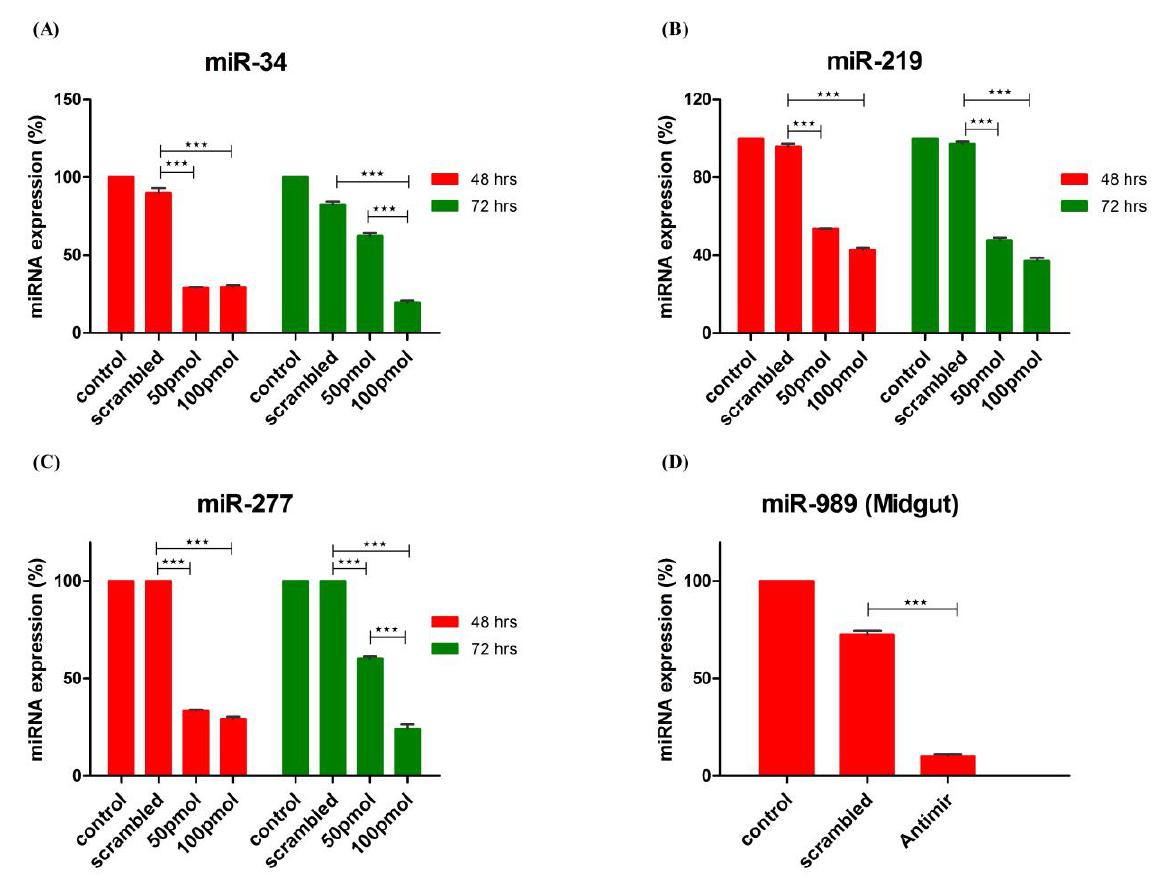
Figure 4. Knockdown of miRNA expression by antagomirs. Knock-down of ( A ) miR-34; ( B ) miR-219 and ( C ) miR-277 expression in cells transfected with 50 pmol and 100 pmol of antagomirs. MicroRNA expression was profiled by RT-PCR at 48 h and 72 h post-transfection in control, scrambled RNA and antagomir transfected cells. Control transfected cells were used as a calibrator, in which expression (%) of miRNA was taken as 100; ( D ) Knock-down of miR-989 by nano-injecting miR-989 specific antagomir in female mosquito. MicroRNA expression was profiled in midgut tissue of PBS, scrambled and antagomir injected female mosquito taking PBS injected mosquitoes as calibrator. Expression (%) of miRNA in PBS injected midgut tissue was taken as 100. Values are mean ± s.e.m. of three biological replicates profiled in triplicate reactions. Data was statistically analyzed by